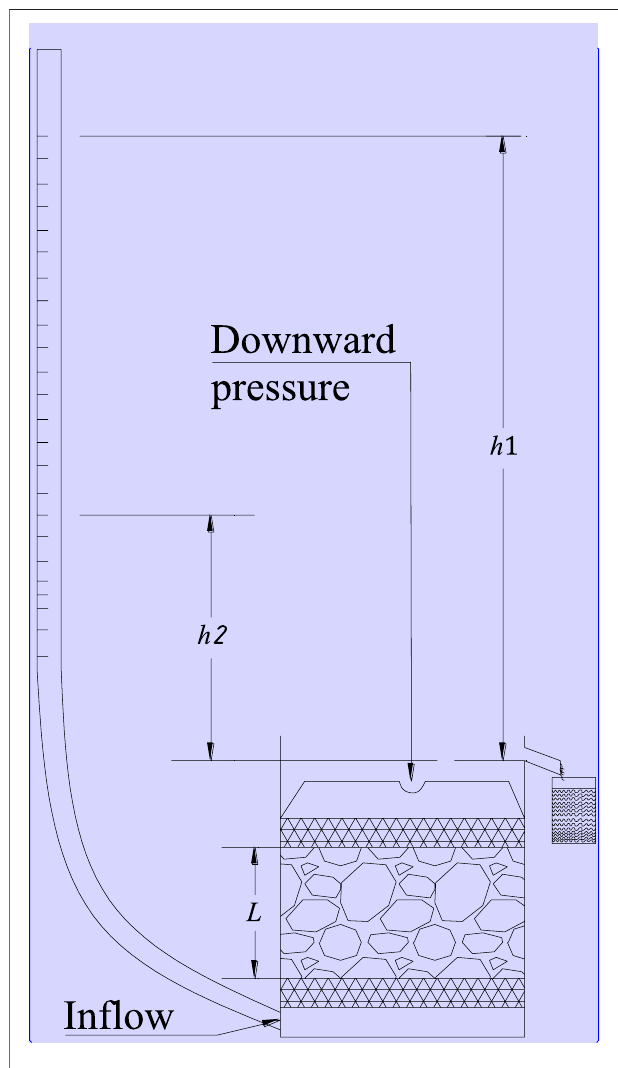
FIGURE 4 | Falling-head permeability